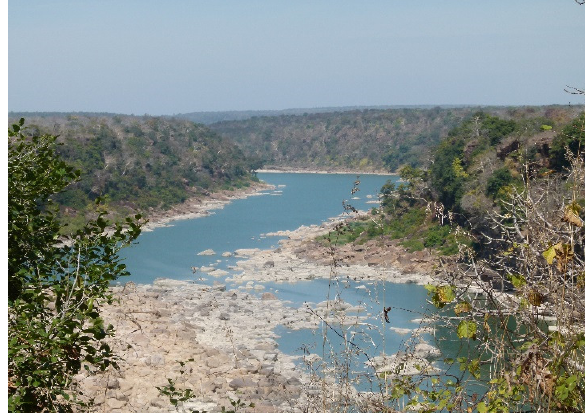
Figure 9. An ideal landscape for cliff nesting vultures. A Dry Deciduous Tropical Forest on plateau (cliff providing nesting ledges and crevices) cut by a meandering river (perennial water source)